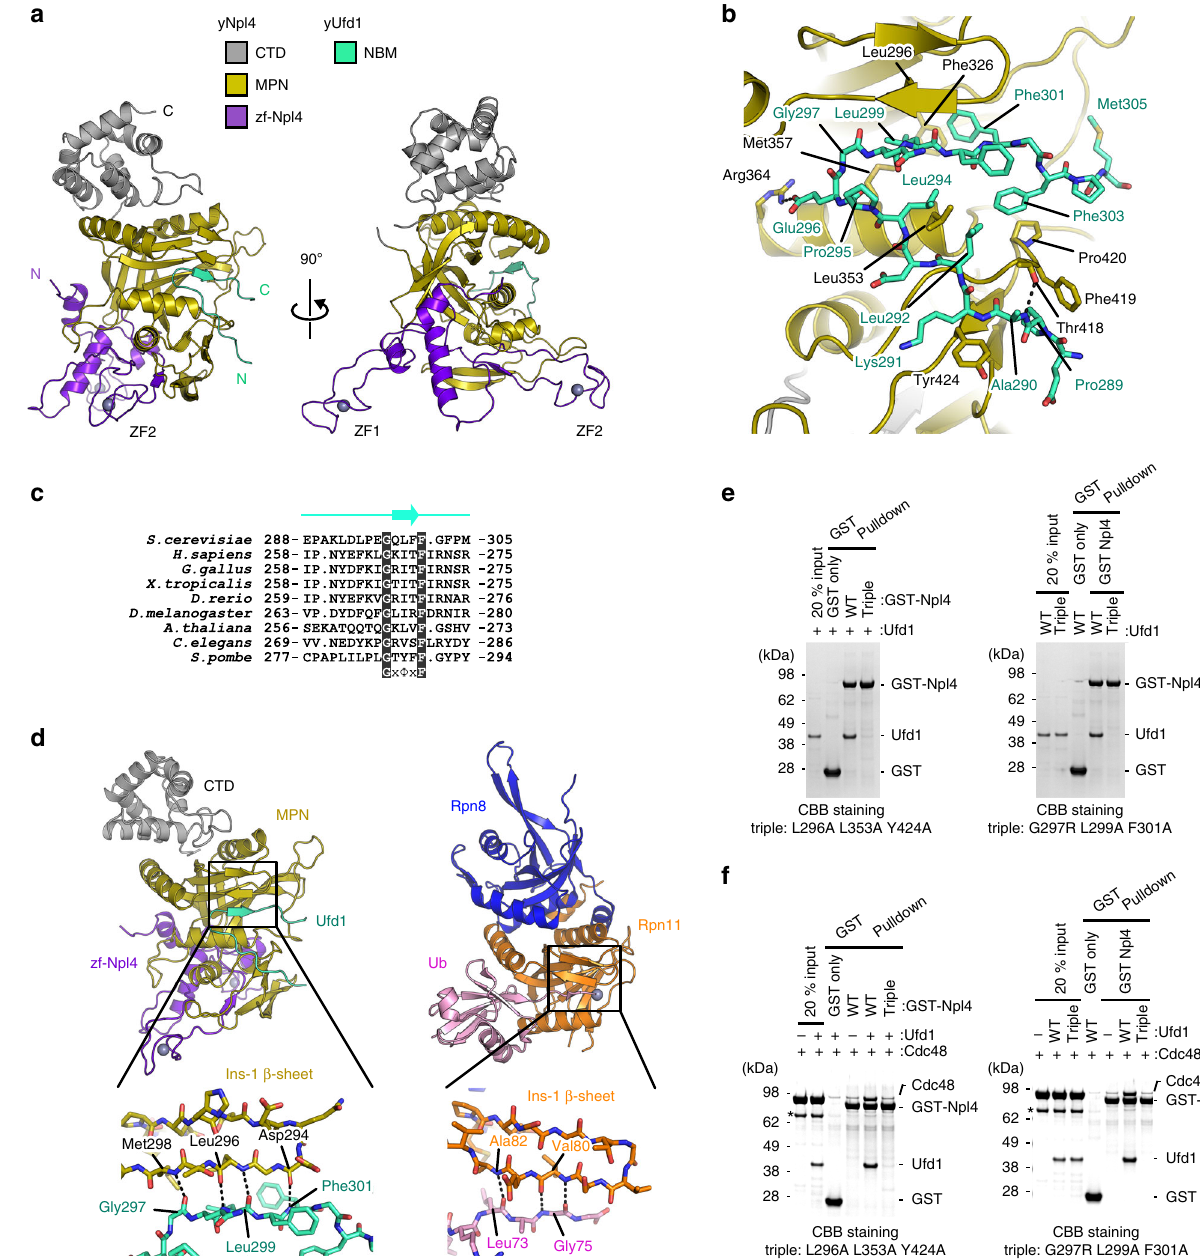
Fig. 3 Crystal structure of yNpl4 in complex with yUfd1. a Overall structure of the yNpl4 – yUfd1 complex in two orientations. b Close-up view of the interaction between yNpl4 and yUfd1. Hydrogen bonds are shown as black dotted lines. c Sequence alignment of the NBM region of Ufd1. The position of the β -strand in the NBM region in the yNpl4 – yUfd1 structure is shown above the sequences. d Comparison of the MPN region of the yNpl4 – yUfd1 and Rpn8 – Rpn11 – Ub (PDB 5U4P [https://doi.org/10.2210/pdb5u4p/pdb]) 25 complexes. The coloring scheme of the yNpl4 – yUfd1 complex is the same as that in Fig. 3a. Rpn8, Rpn11, and Ub of the Rpn8 – Rpn11 – Ub complex are blue, orange, and pink, respectively. Hydrogen bonds are shown as black dotted lines. e , f Analysis of the binding between GST-yNpl4 and yUfd1 alone ( e ) or yUfd1 – Cdc48 ( f ) by pulldown assays. The results from the triple mutant of yNpl4 (L296A L353A Y424) (left) or the triple mutant of yUfd1 (G297R L299A F301A) (right) are shown. In all, 20% input means 20% of the volume of the sample (yUfd1 and/or Cdc48) that was mixed with the GST-yNpl4-bound glutathione resin. Asterisks indicate contamination. The bound proteins were analyzed by SDS-PAGE and stained with Coomassie brilliant blue. Source data are provided as a Source Data fi